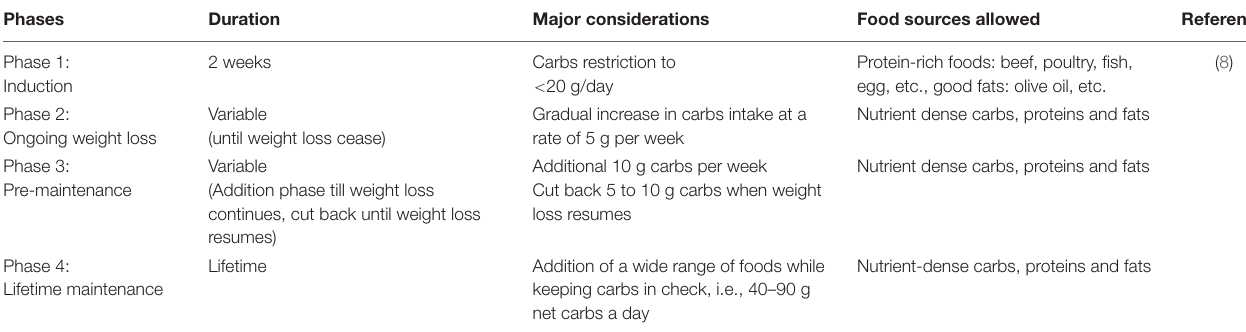
TABLE 1 | Phases of the Atkins